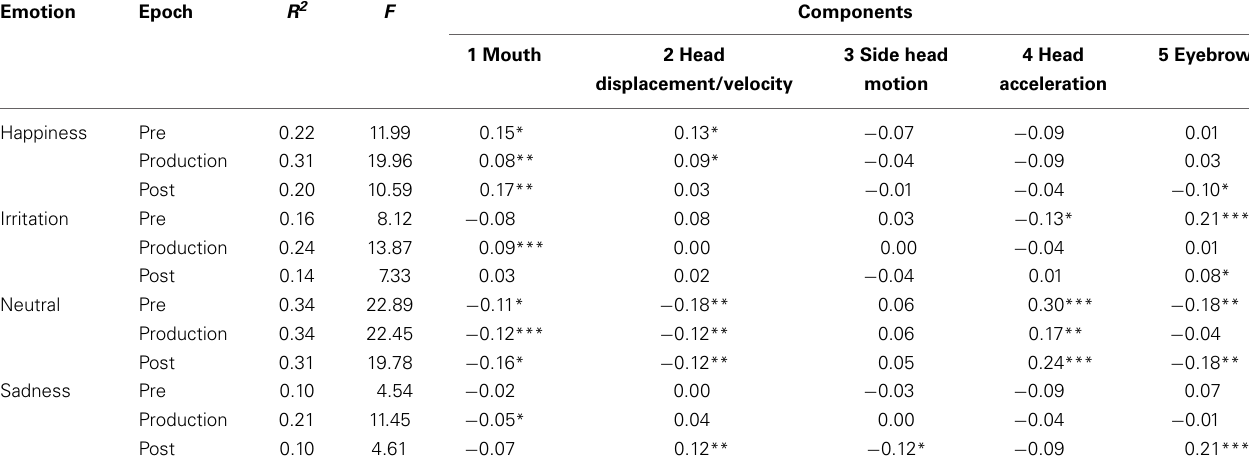
Table 2 | The coefficient of determination, F -value and regression coefficients associated with the regression analyses with the components as predictors of emotion in each of the three